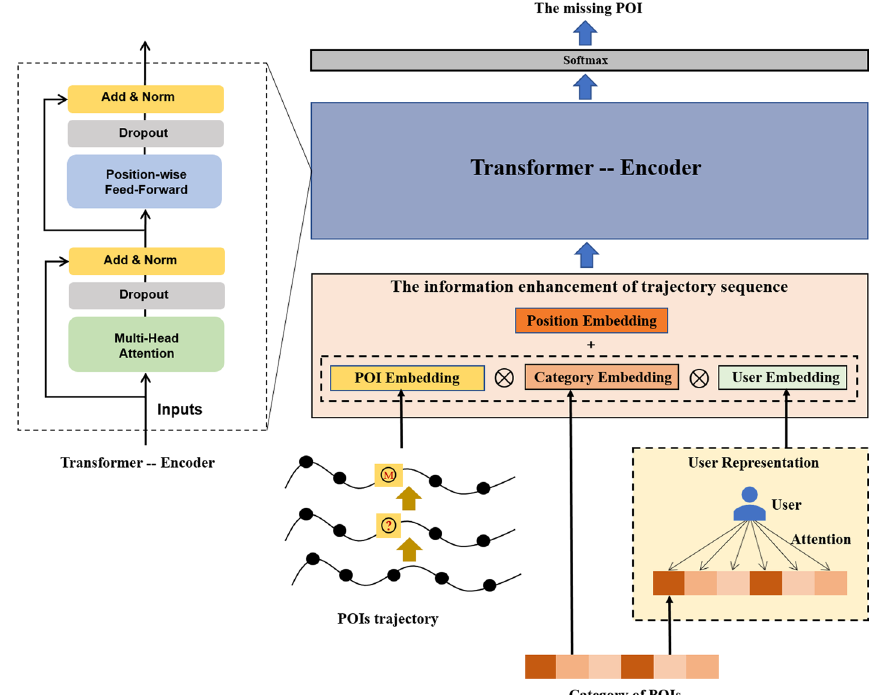
Fig. 2 Framework of the proposed